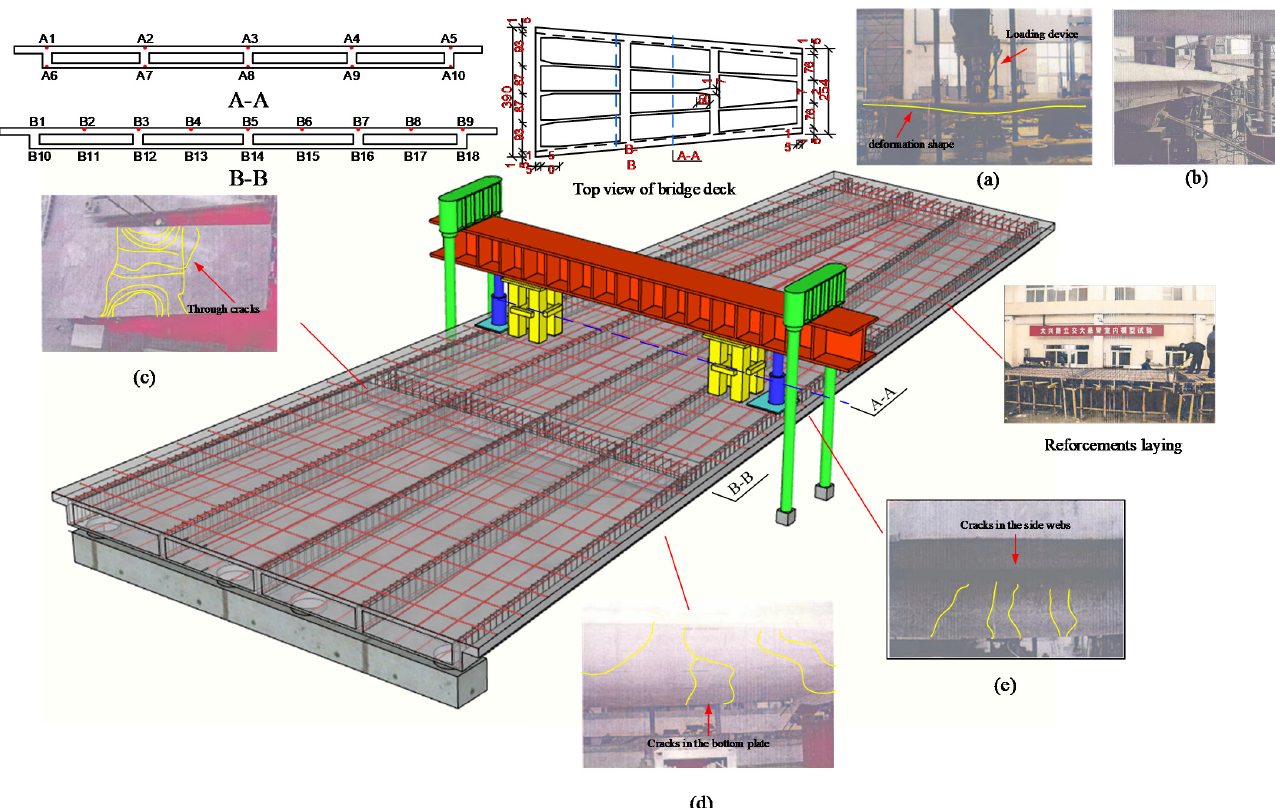
Figure 3. Test loading diagram and test phenomenon: ( a ) loading device; ( b ) deformation state; distribution of cracks in the ( c ) top slab; ( d ) bottom slab in the span; ( e ) side slab in the span.